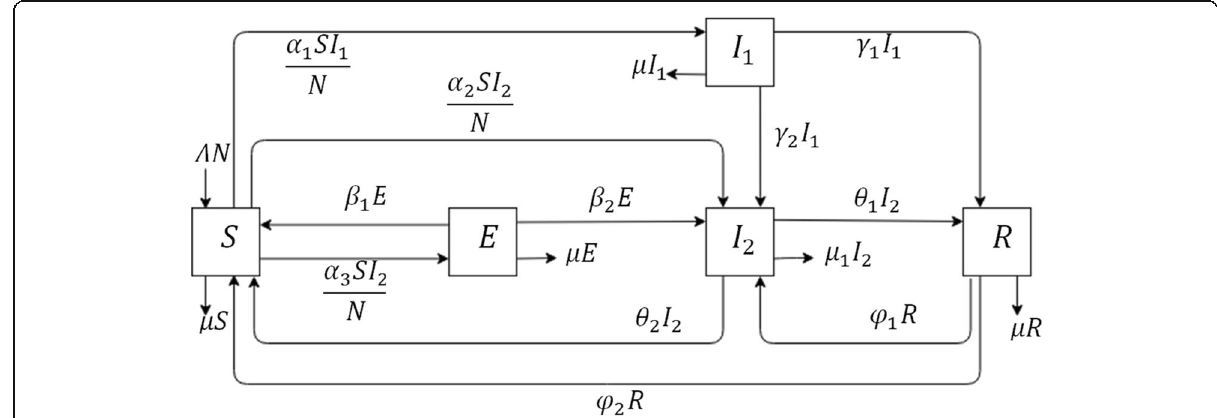
Fig. 2 Flowchart of COVID-19 Transmission in